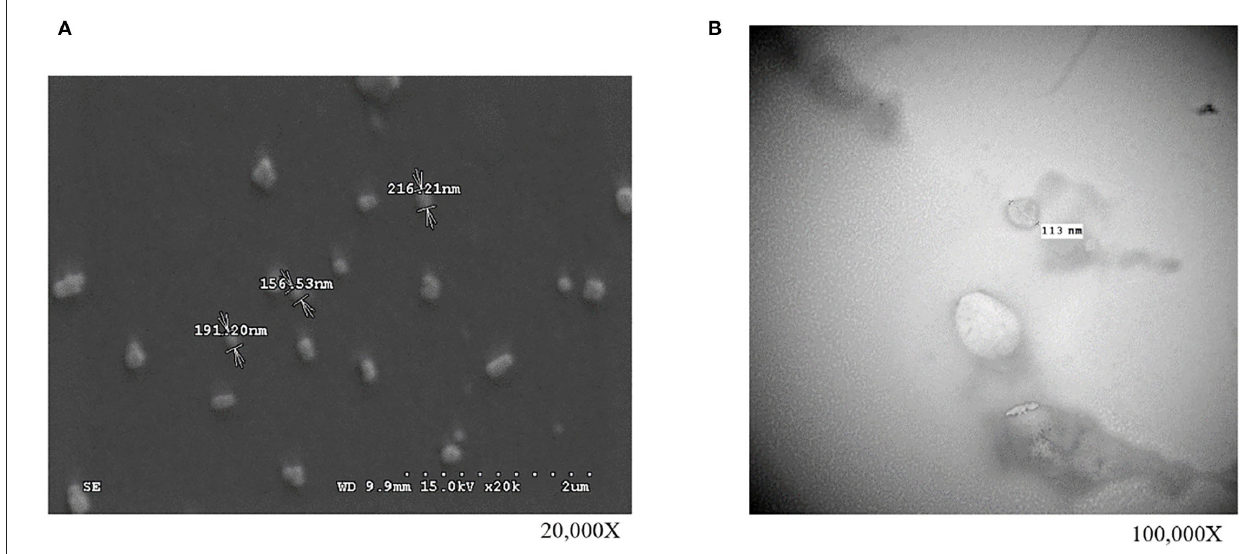
FIGURE 2 | The analysis of the sizes of EVs secreted by PFTSCs which were collected and isolated from M199 medium (in each plate, and repeated thrice).